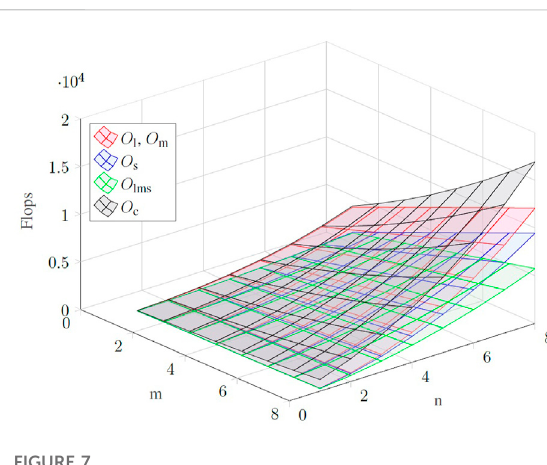
FIGURE 6 STPD and LMS convergence behavior for the proposed example.